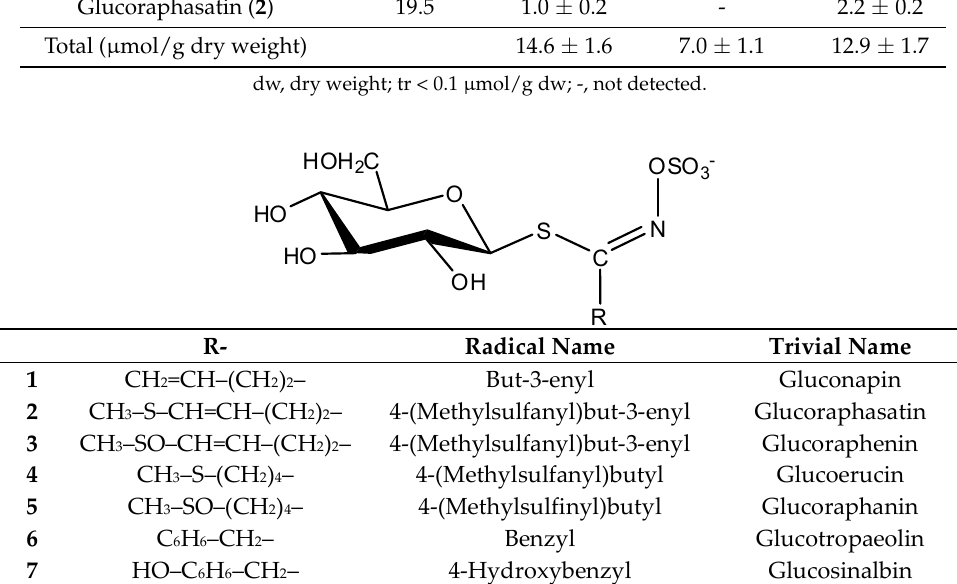
Figure 1. Glucosinolates identified in different parts of B. erucago.